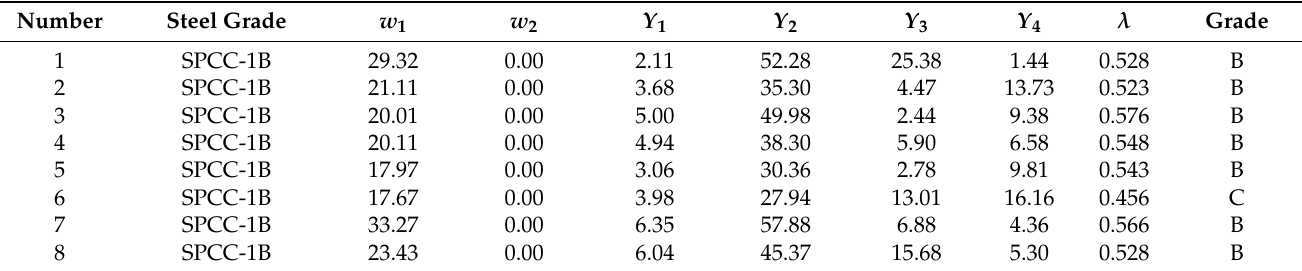
Table 4. Results of flatness quality comprehensive evaluation.